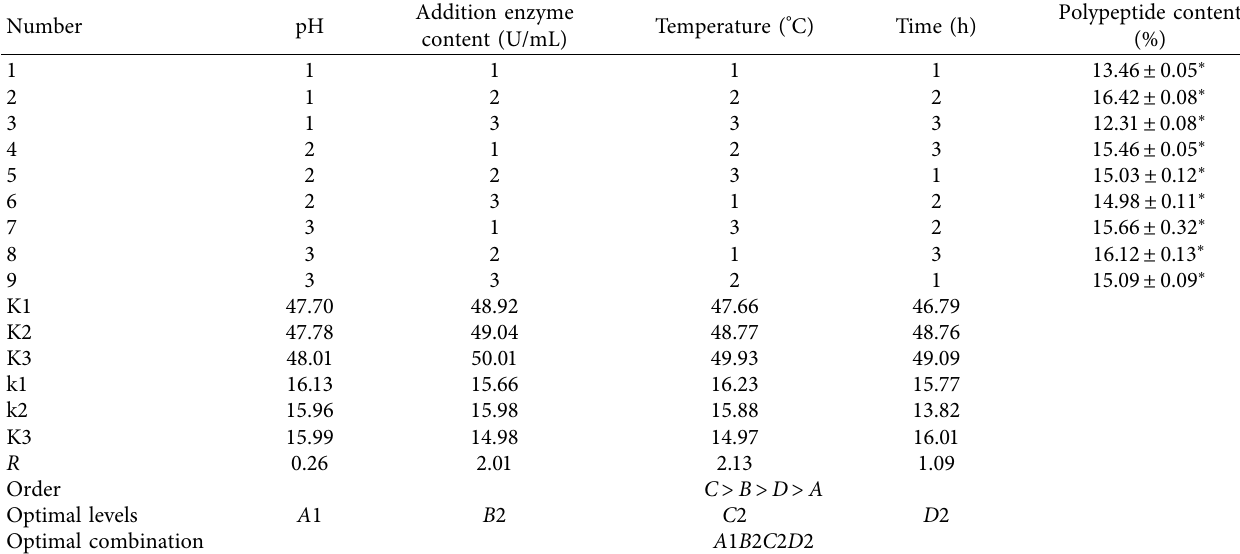
Figure 4: Efect of pH (a), the compound enzyme addition amount (b), enzymatic hydrolysis time (c), and temperature (d) on the polypeptide contents. Table 5: Results and analysis of the orthogonal test of C. militaris